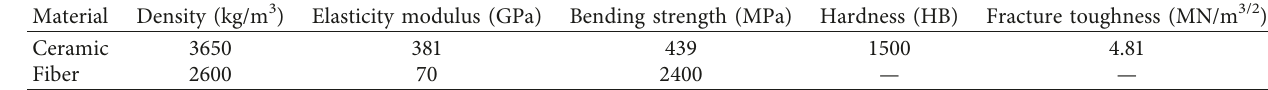
Table 2: Material parameters of ceramic and fiber.